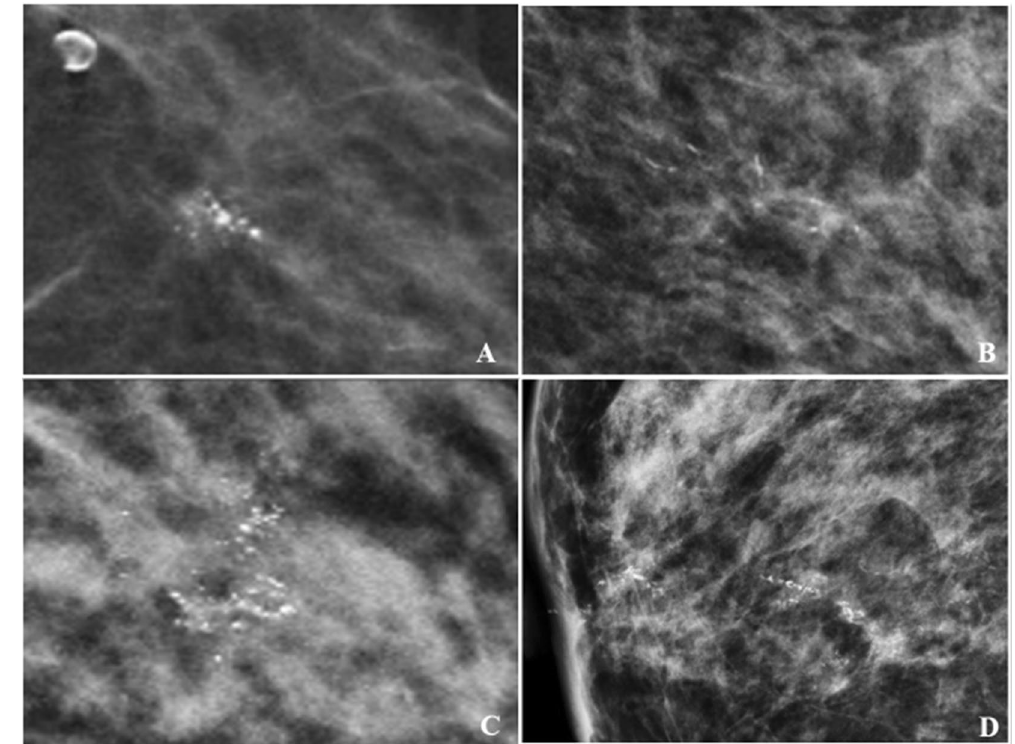
Figure 4. Calcifications morphology with malignant histopathology on VABB. Example of coarse heterogenous calcification in a grouped distribution – low-grade DCIS ( A ). Amorphous calcifications in